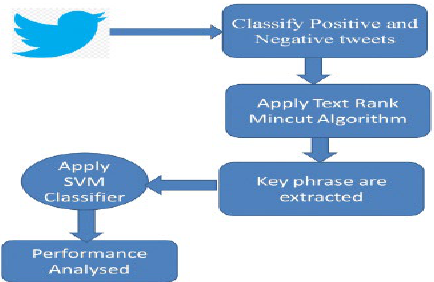
Fig. 2. Architecture Diagram for Health Detection